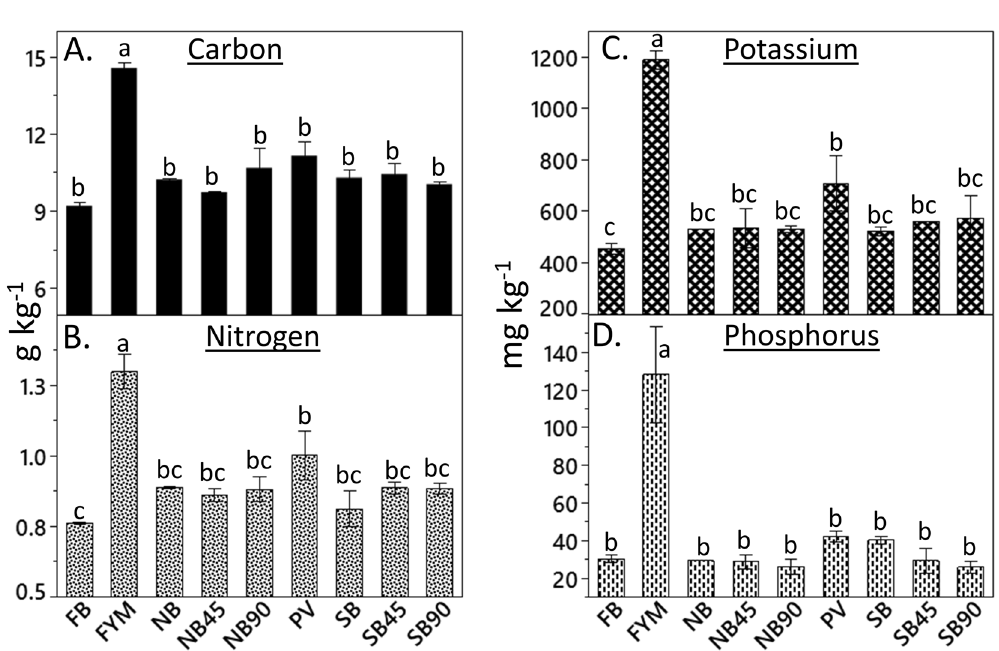
Figure 2. The effect of 84 years of residue management methods on soil nutrients in upper 10 cm soil surface. ( A ) Concentration of soil organic carbon, ( B ) Concentration of total nitrogen, ( C ) Concentration of Mehlich III extractable potassium, and ( D ) Concentration of Mehlich III extractable phosphorus. Bars sharing the same letter are not significantly different at the 0.05 probability level. FB = Fall burn; FYM = Farmyard manure; PV = Pea vine; NB = No burn; SB = Spring burn; and 45 and 90 after NB and SB represents the rates (kg ha − 1 ) of inorganic N applications in respective